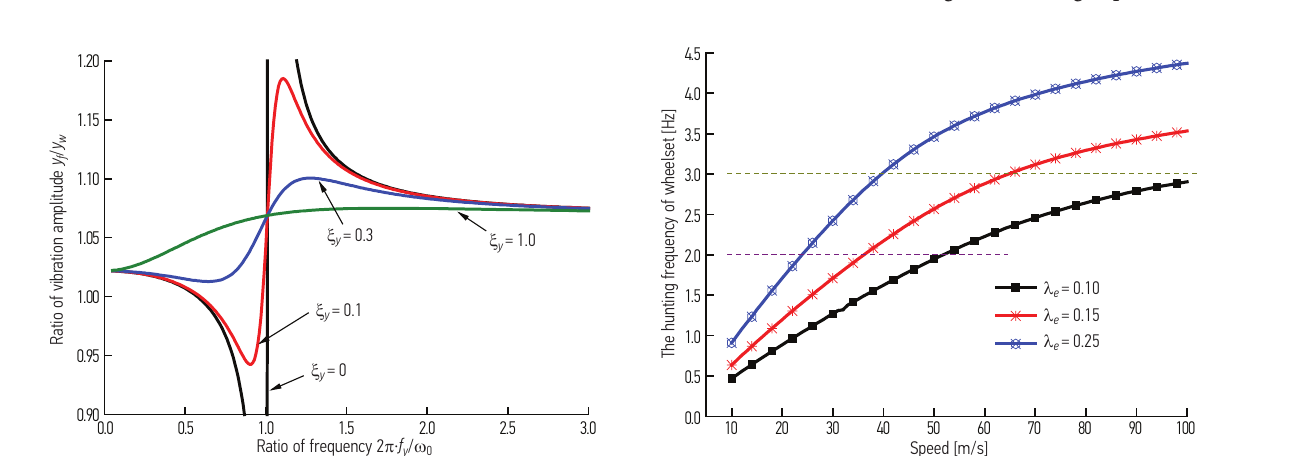
Fig. 12. The hunting frequencies of wheelsets with the different speed and wheel conicities λ